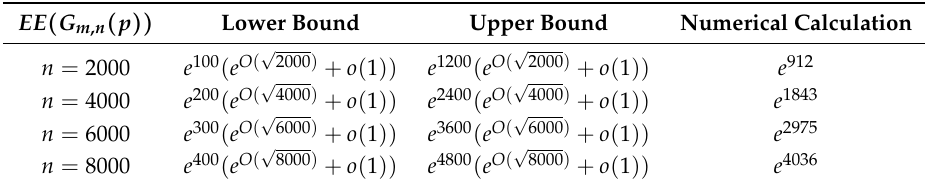
Table 1. EE ( G m , n ( p )) for m = 2, n ( 1 ) = n /2 and p =